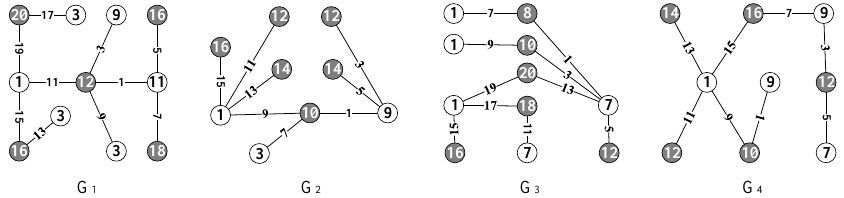
Figure 1. Four graphs G 1 , G 2 , G 3 , G 4 admit set-ordered odd-graceful total